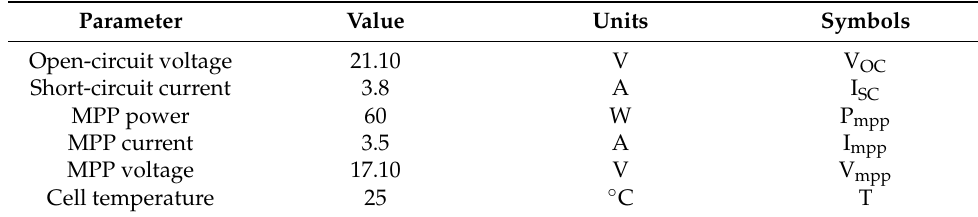
Table 1. Parameters for the [MSX60] Solarex photovoltaic module at 1000 W/m 2 .